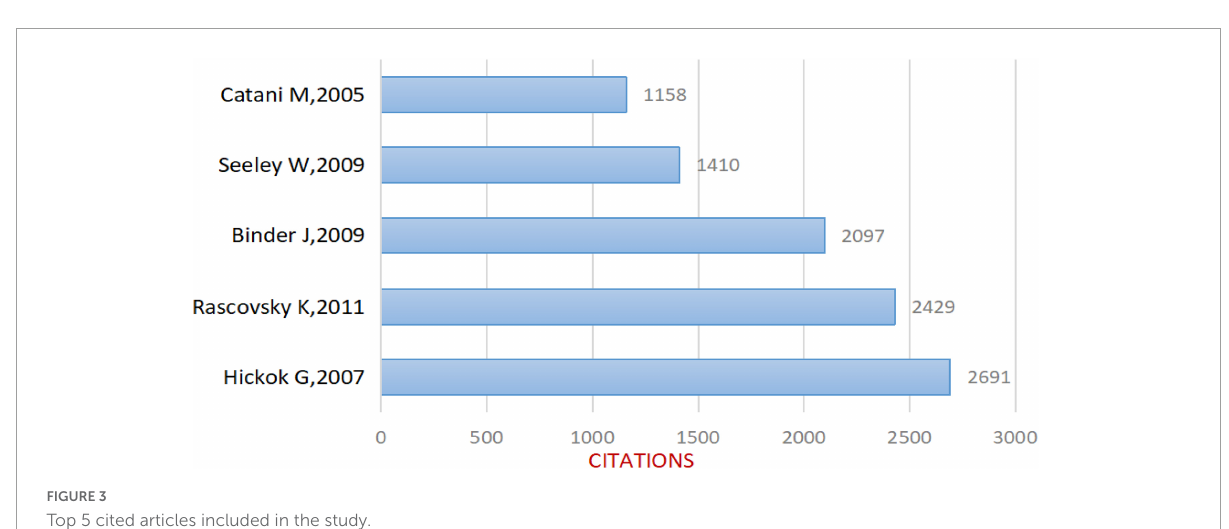
FIGURE3 Top 5 cited articles included in the study.